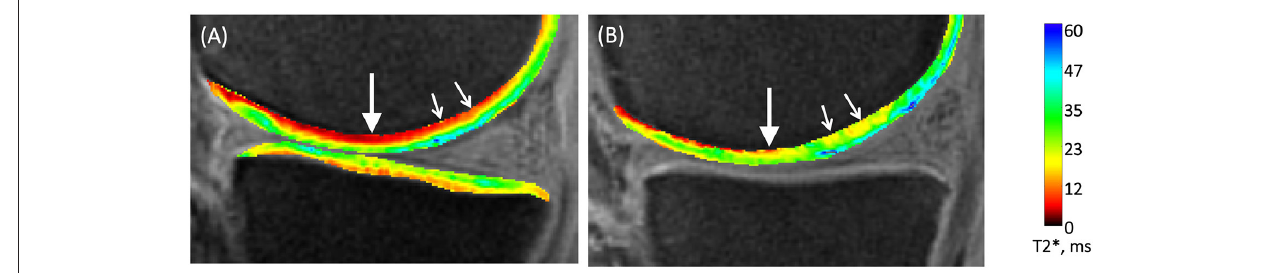
FIGURE 10 | Compositional MRI of two human knees using UTE-T2* mapping. (A) UTE-T2* map of an un-injured human knee shows a lower signal (red) in the deeper layers of the articular cartilage (arrows). (B) UTE-T2* map of a knee acutely following an ACL-injury, shows a higher more disorganized signal pattern in the deeper layers of the articular cartilage. MRI – Magnetic resonance imaging; UTE – ultrasound time echo; ACL – anterior cruciate ligament. Chu C et al. Visualizing Pre-osteoarthritis: Integrating MRI UTE-T2* with mechanics and biology to combat osteoarthritis—The 2019 Elizabeth Winston Lanier Kappa Delta Award. Journal of Orthopedic Research. 2021; (1–11). Reprinted with